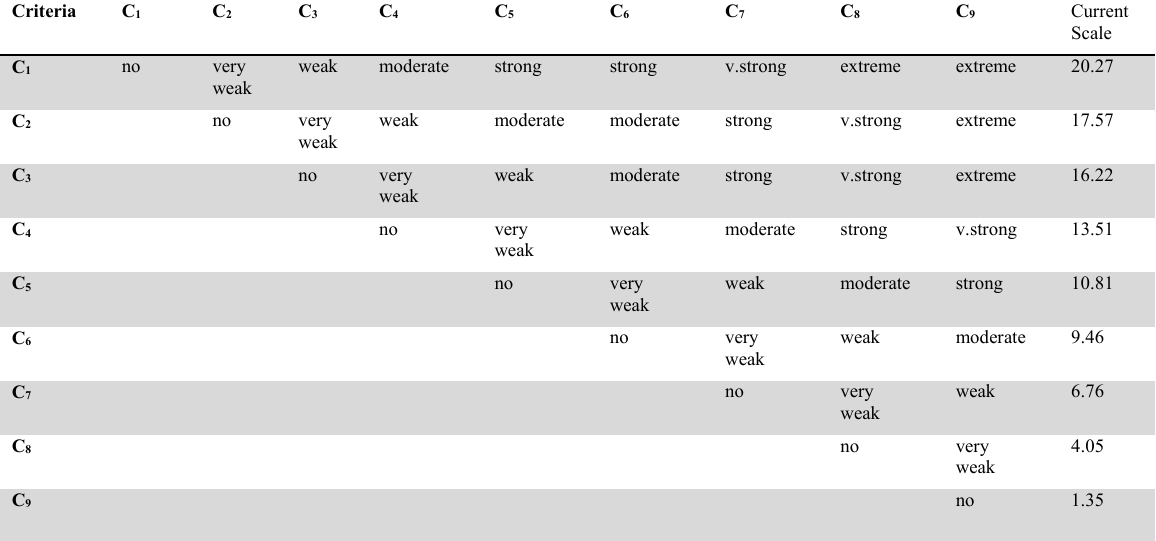
Figure 2. MACBETH value tree for air compressor selection problem Comparison of the